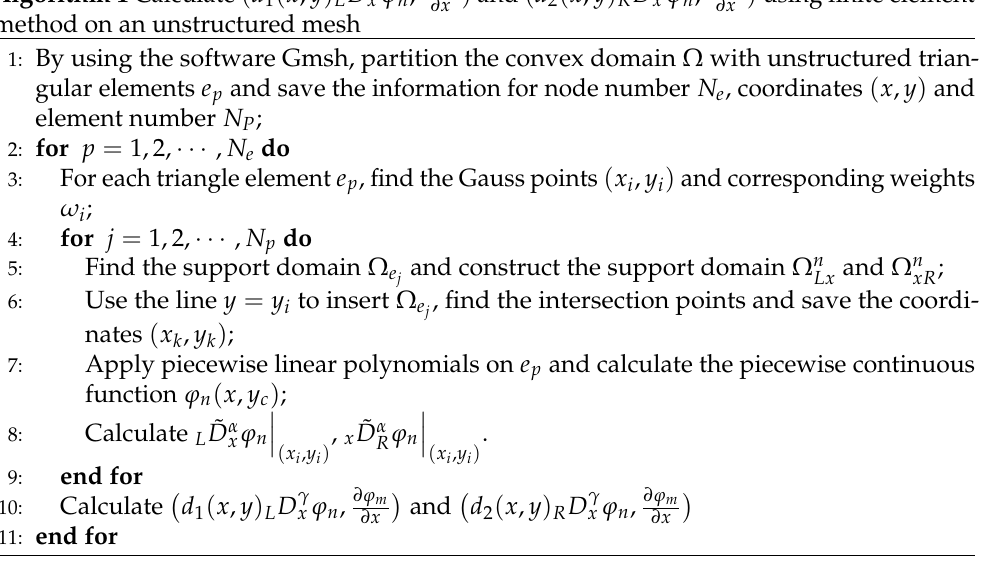
∂ϕ m γ ) and ( d ) using finite element ( x , y ) R D x ϕ n , 2 ∂ x ∂ x